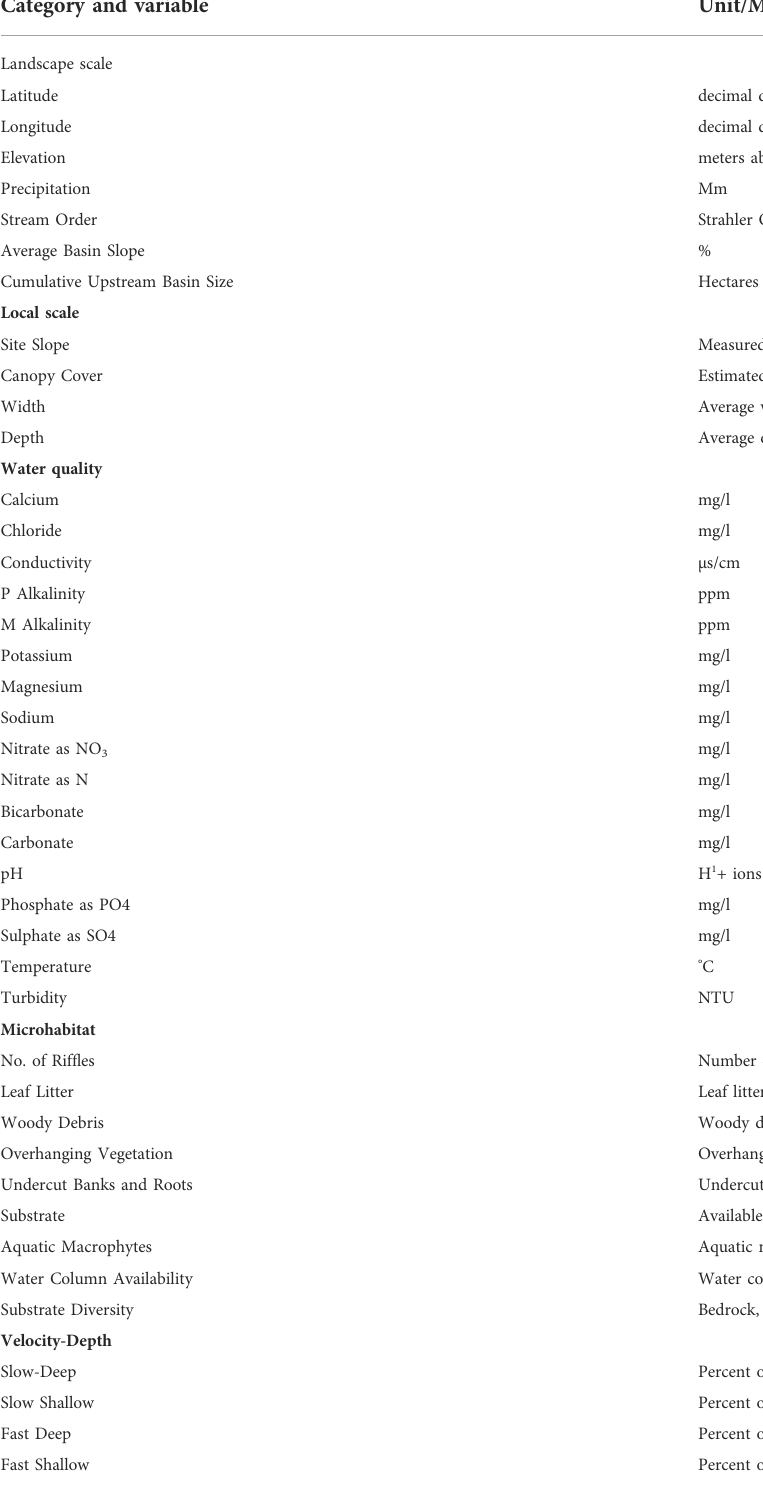
TABLE 1 Landscape and local environmental and physical variables measured at sites in lower and upper basin of the Kouilou-Niari